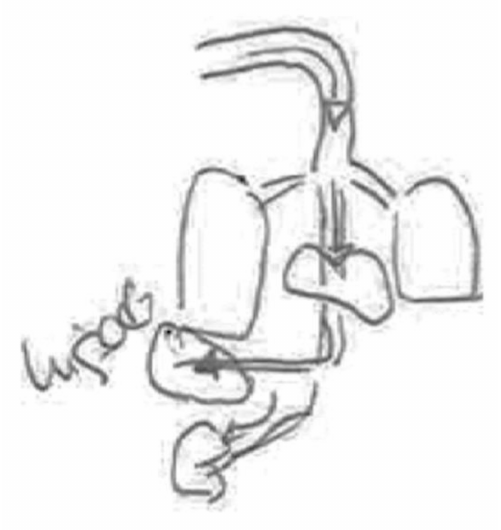
Figure 4. Pregnant, university education,